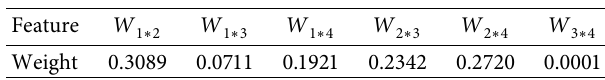
Table 4: The weight considering multifactor interaction influence.